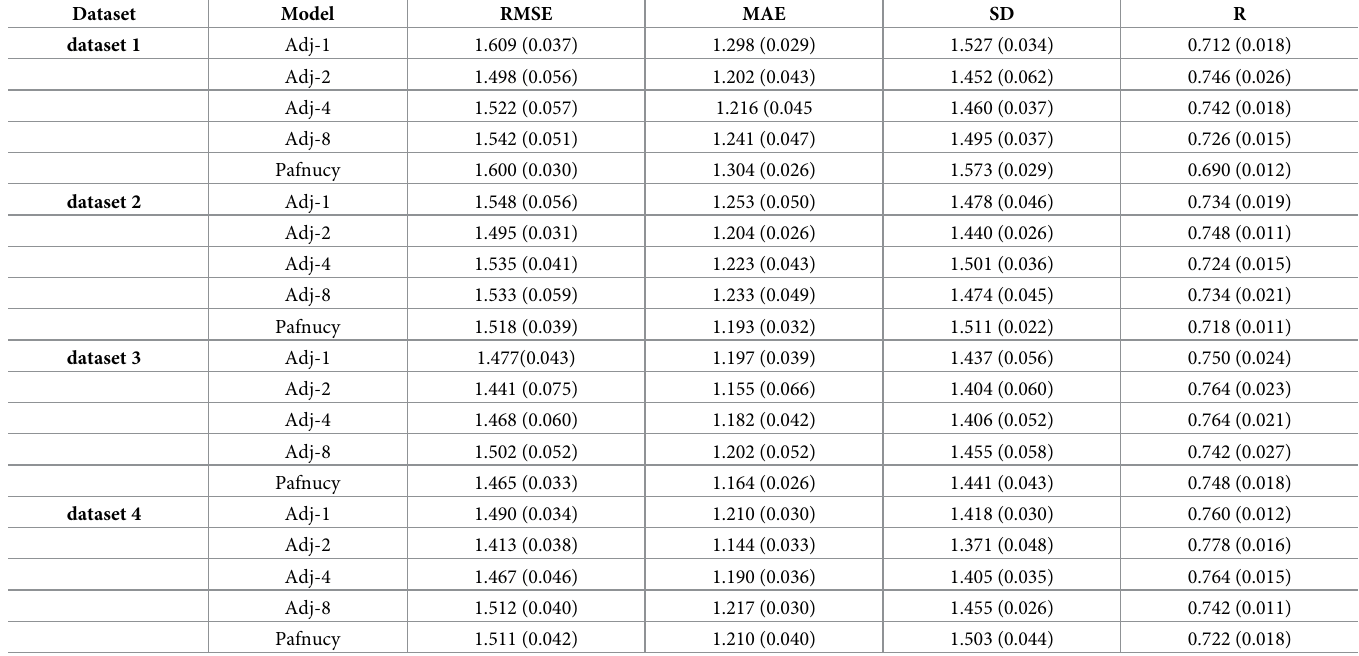
Table 3. The performance of GraphBAR on the PDBbind v.2016 core set.